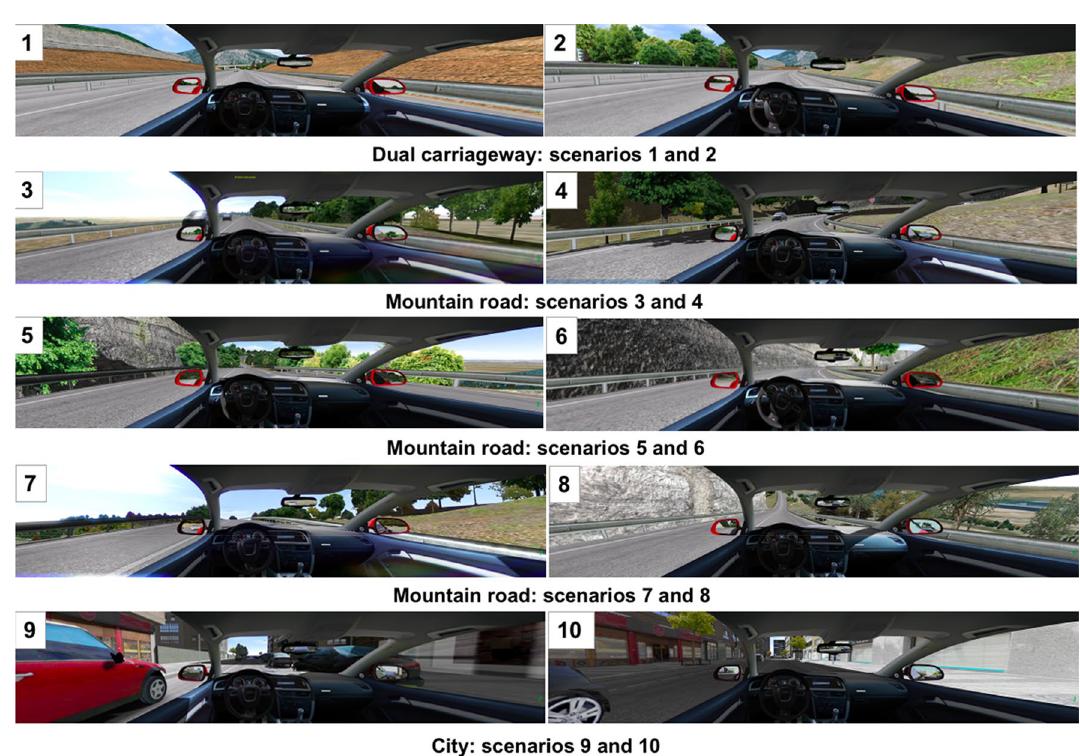
Figure 1. Screenshots of the different scenarios used in the